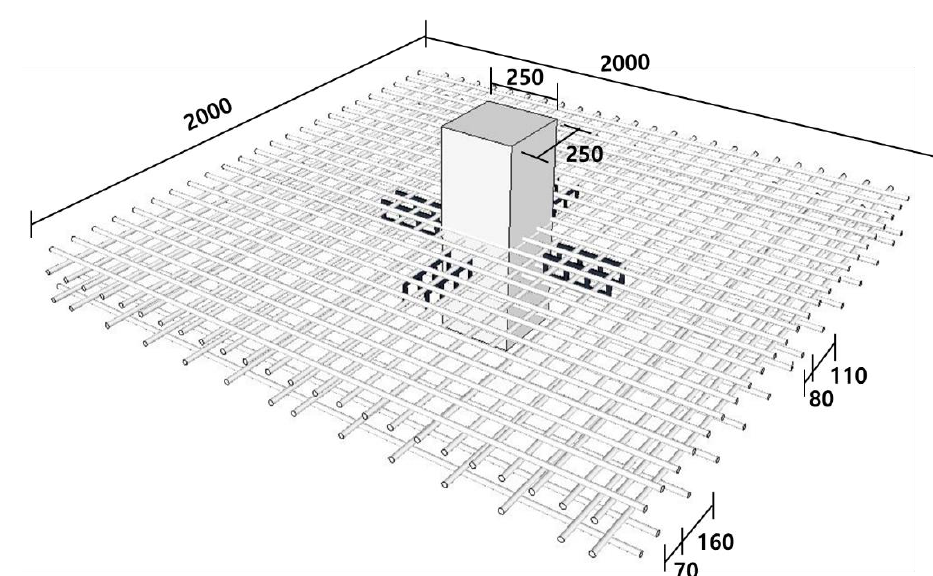
Figure 3. Schematic view of the test specimen.